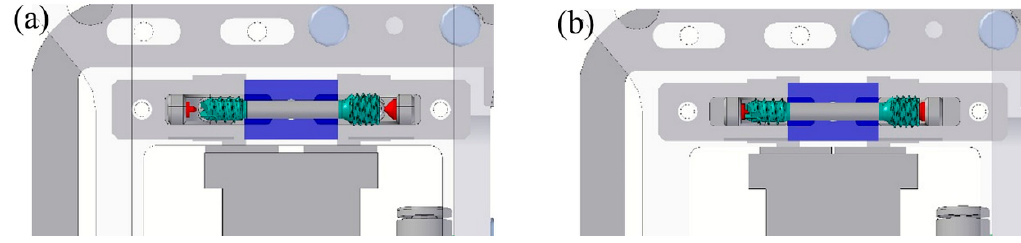
Figure 13. Screw gripper (red bits) ( a ) opened and ( b ) closed.